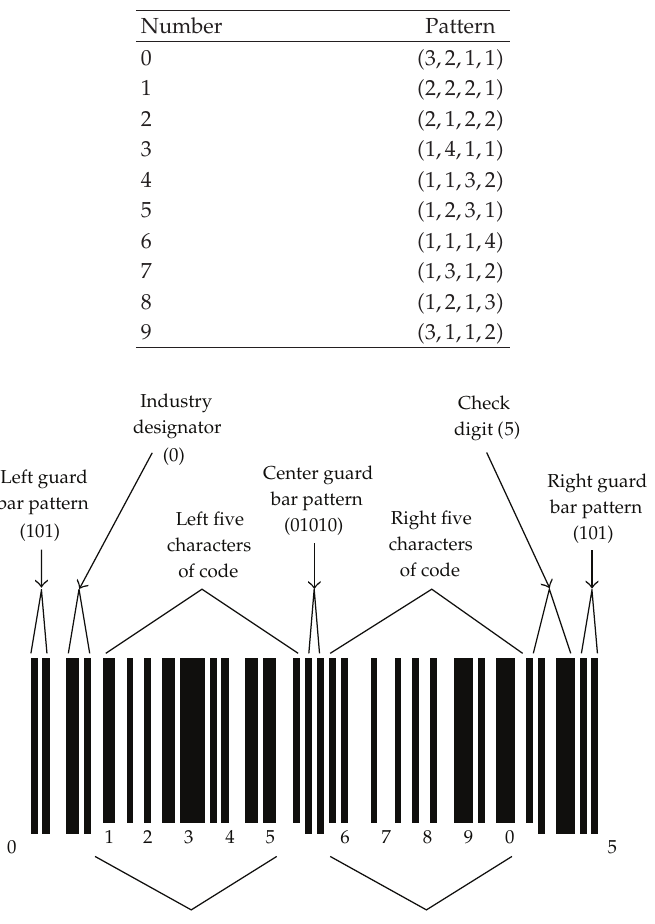
Figure 1: UPCA bar code encoding the digits